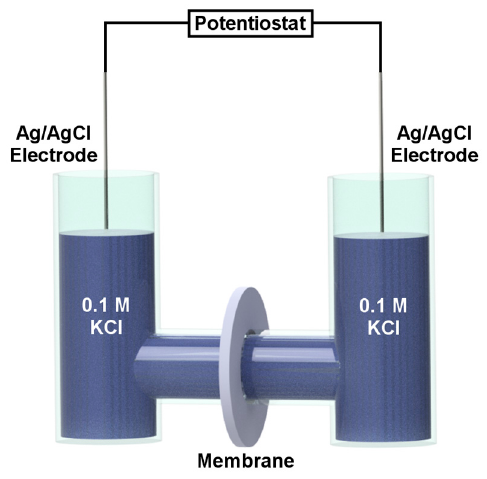
Figure 5. Schematic illustration of a U-tube cell used to measure current-voltage (I-V) curves associated with ion transport through the membrane. Dimensions are not to scale.